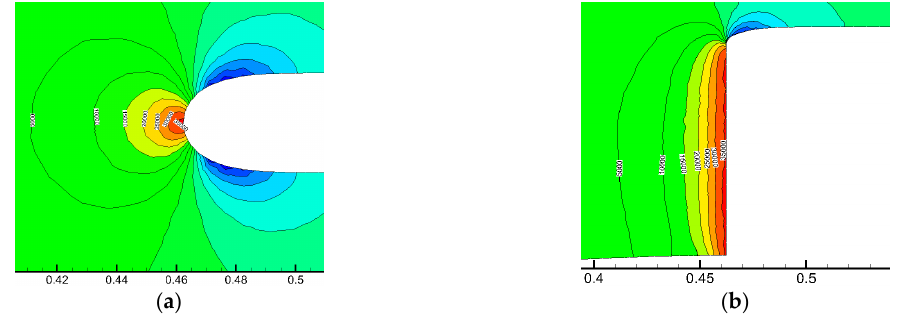
Figure 5. Pressure contours at different reference planes: ( a ) plane A; and ( b ) plane B. The pressure gradient is adverse when the points are approaching the leading edge.